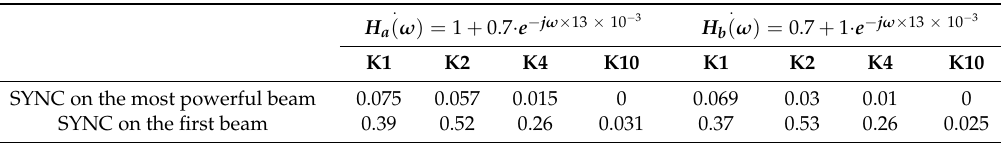
Table 4. BER for different modes of FM-OFDM for channels with responses H a ( ω ) and H b ( ω ) under SNR of 15 dB and different synchronization